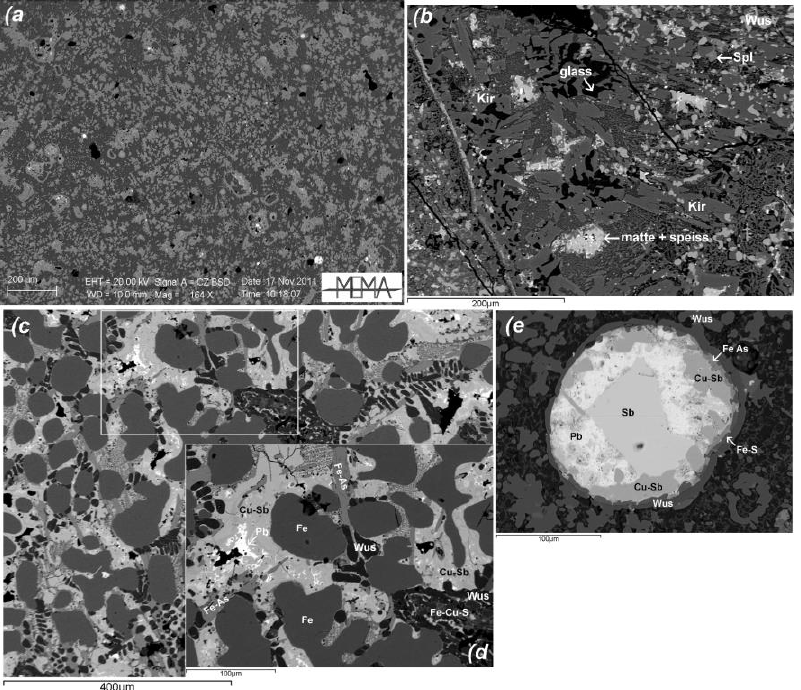
Figure 4. Backscattered electron (BSE) images of Fe-rich matte slags from Cugnano: ( a ) panoramic view with wüstite dendrites (medium grey); ( b ) kirschteinitic olivine, glass, wüstite/spinels, and matte/speiss inclusions; ( c ) particular of a matte/speiss inclusion with many metallurgical sul- fides and metals, enlarged in ( d ); ( e ) Pb droplet with Sb and Cu-Sb phases. Abbreviations: Kir— kirschsteinite; Wus—wüstite; Spl—zoned